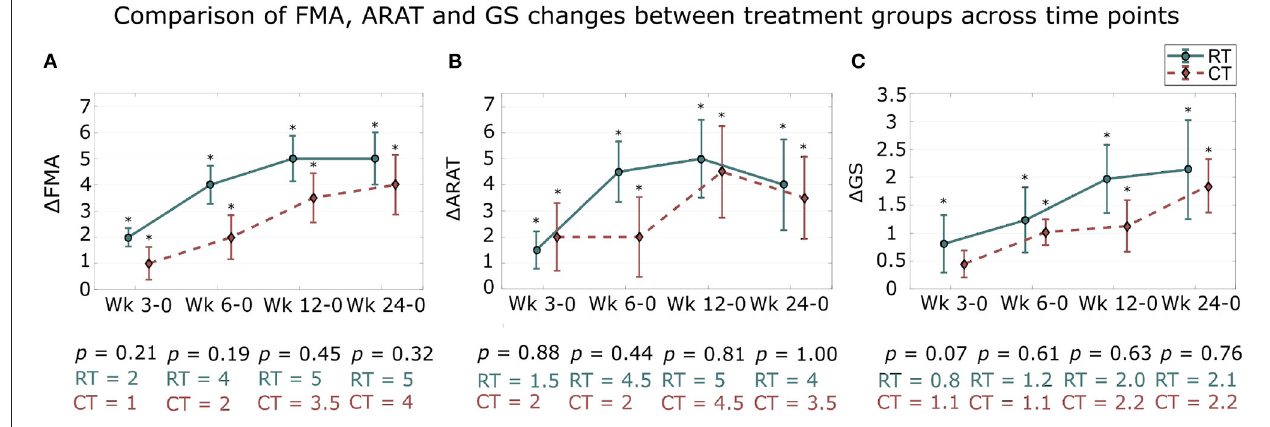
FIGURE 3 | Changes in clinical outcome measures from baseline assessment across sessions. The changes in clinical measures over 24 weeks in comparison with the baseline assessment (week 0) are presented. Median and standard error of the changes in: (A) FMA, (B) ARAT, and (C) GS for the robotic therapy (RT) and conventional therapy (CT) groups are shown. The * signifies that the changes compared to baseline are significant ( p < 0.05). Wk, week. The indicated p -value corresponds to the between treatment group differences in clinical scale changes compared to baseline at each assessment session.